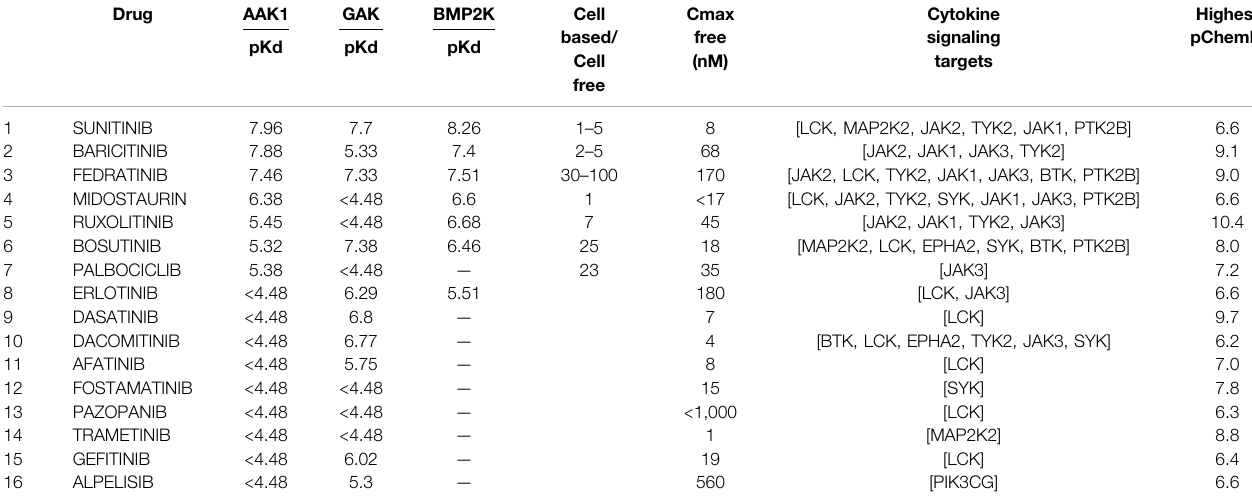
TABLE4| Approveddrugsassociatedwithbothendocytosisandcytokinesignaling.ThedrugsapprovedbytheFDAorEMAareindicatedwiththeirreportedpKdvaluesfor AAK1, BMP2K and GAK, and the targets in the cytokine signaling module ( Figure 5 ) which they are reported to inhibit are listed. The highest pChembl value is that reported for the fi rst listed target (i.e. for baricitinib the pChembl value is for JAK2). The drugs are listed in order of af fi nity for AAK1.